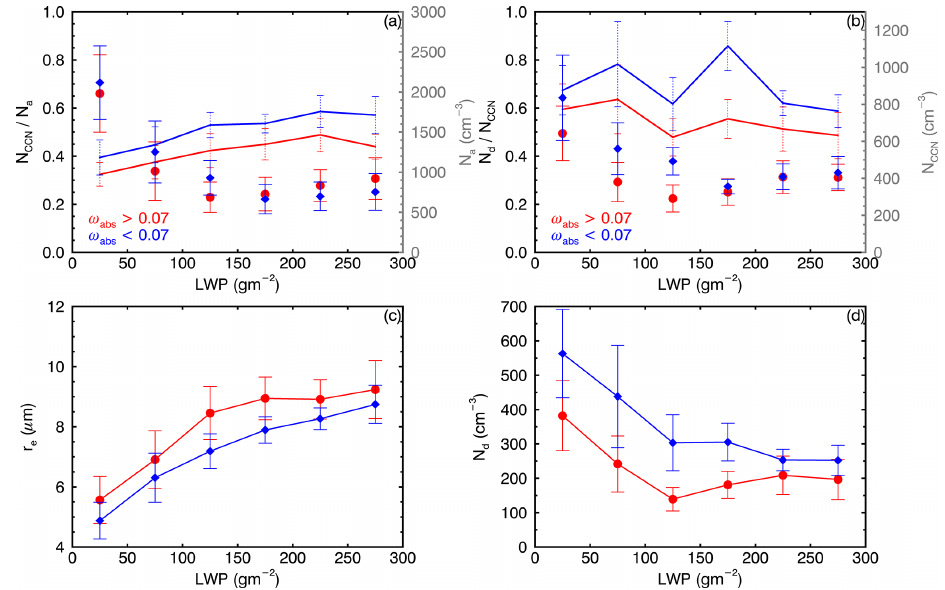
Figure 7. (a) N a (dot) and the ratio of N CCN to N a (line), (b) N CCN (dot) and the ratio of N d to N CCN (line), (c) r e , and (d) N d as a function of LWP under strongly absorptive (in red) and weakly absorptive (in blue) aerosol regimes. Whiskers denote 1 standard deviation for each